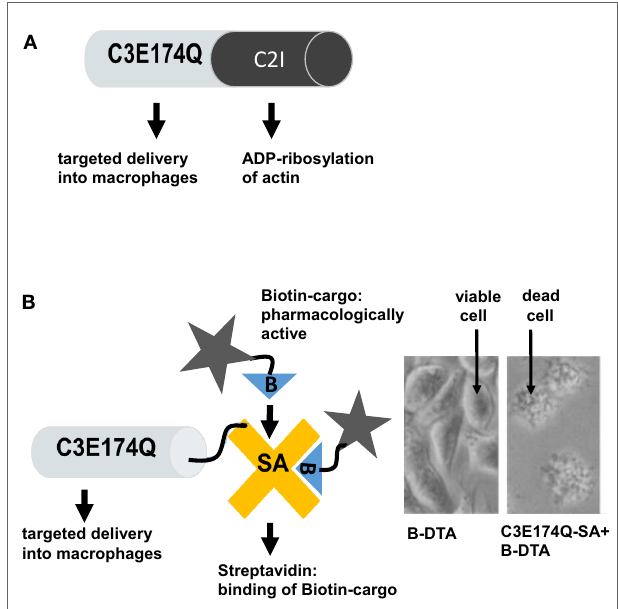
FiguRe 2 | Recombinant fusion proteins based on enzymatically inactive C3bote174Q for the targeted delivery of pharmacologically active molecules into the cytosol of macrophages and modulation of macrophage functions . (A) Schematic representation of the recombinant C3botE174Q-C2I fusion toxin, which specifically ADP-ribosylates G-actin in macrophages, resulting in depolymerization of the actin filaments and inhibition of actin-dependent cell functions. (B) Schematic representation of the recombinant C3botE174Q-Streptavidin (indicated as C3botE174Q-SA) fusion protein, which serves as transporter for the targeted delivery of biotinylated (indicated as B-) pharmacologically active cargo molecules into the cytosol of macrophages, which are alone not taken up, in order to specifically modulate macrophage functions (left panel). Right panel: the enzyme domain of diphtheria toxin (DTA), which ADP-ribosylates elongation factor 2 in cells and triggers cell death, was biotinylated and used as a model cargo for proof-of-concept. J774A.1 macrophages incubated with biotin-labeled DTA (B-DTA) or with B-DTA, which was previously bound to the transporter molecule C3botE174Q-SA. When B-DTA was delivered into the cytosol by C3botE174Q-SA the cells died, while cells treated with B-DTA alone stayed viable [modified from Christow et al.